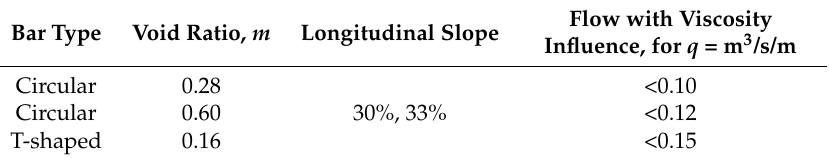
Table 2. Viscosity influence in the flow depth at the beginning of the rack for 30% and 33% longitudinal slopes.